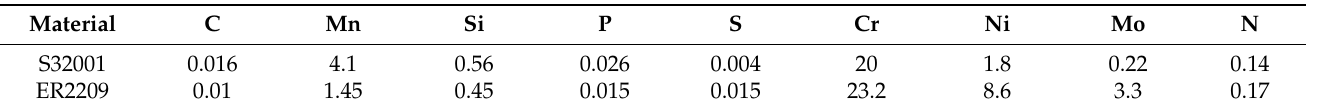
Table 1. Chemical composition of duplex stainless steel (DSS) UNS S32001 and filler metal ER2209 (wt